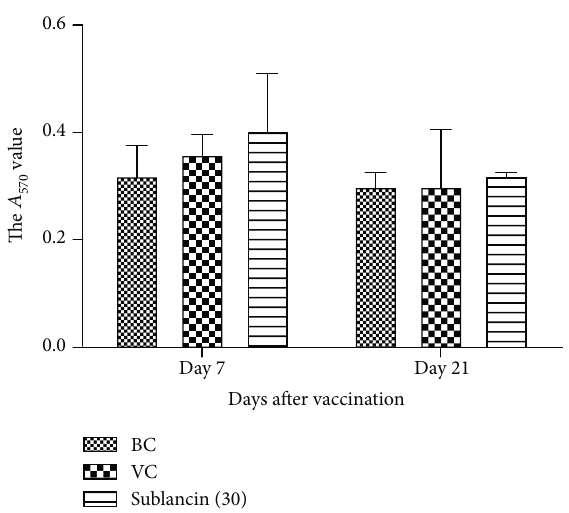
Figure 3: E ff ect of sublancin on pinocytosis of peritoneal macrophages in Exp. 3.